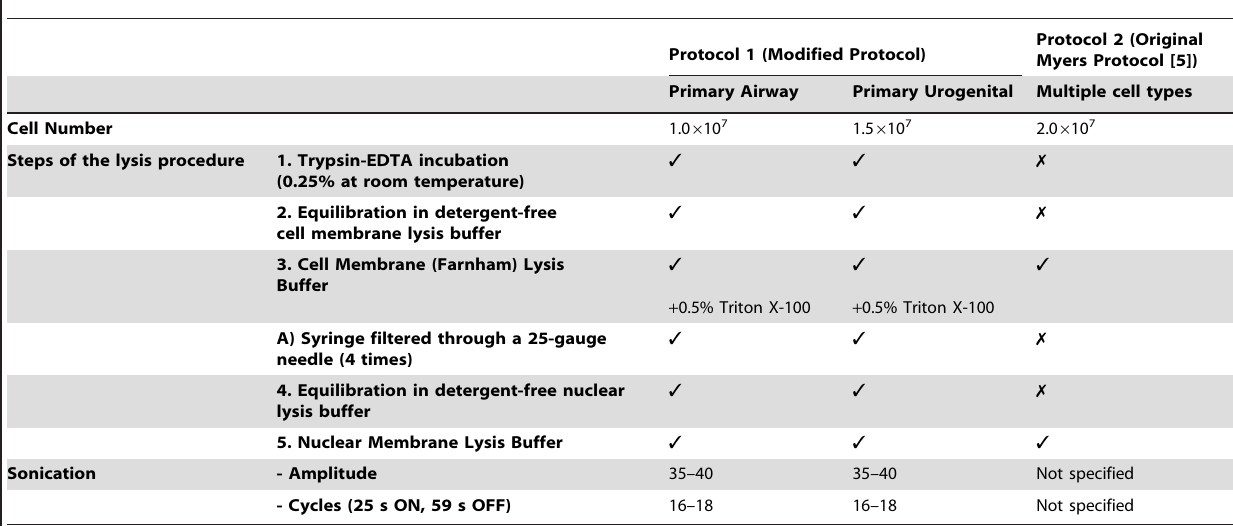
Table 1. A comparison of modified (protocol 1) and unmodified (protocol 2) Myers Lab Protocol [5]) for the isolation of primary epithelial cell chromatin for